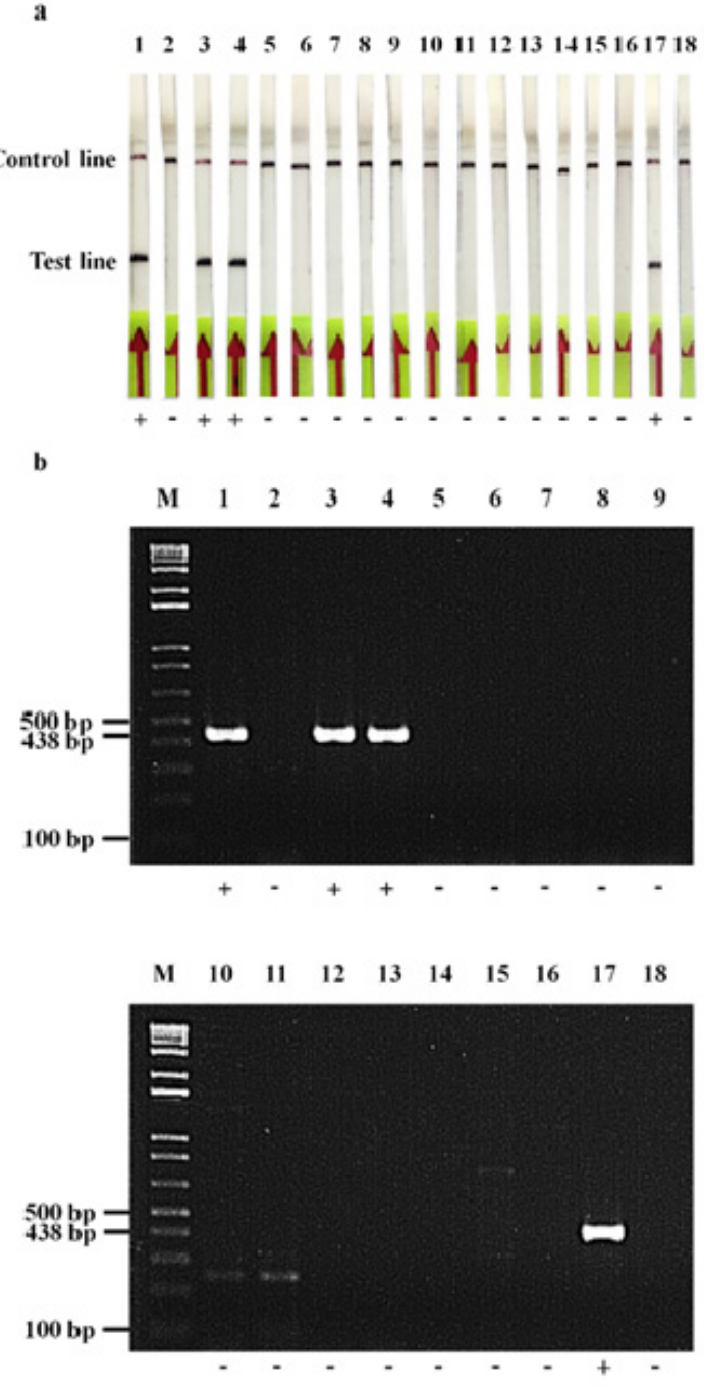
Figure 3. The RPA products of the bla OXA-48-like from the reference strains and clinical isolates detected by the RPA-LF ( a ), and PCR-AGE ( b ), assays. M, 1 kb plus DNA ladder; 1, bla OXA-48 positive control strain; 2, negative control strain; 3, E. coli ( bla OXA-48-like ); 4, E. coli ( bla OXA-181 ); 5, K. pneumoniae ATCC BAA-1705 ( bla KPC-2 ); 6, E. cloacae ( bla IMI-1 ); 7, E. coli ( bla NDM ); 8, K. pneumoniae ( bla IMP-14a ); 9, P. aeruginosa ( bla VIM-2 ); 10, A. baumannii ( bla OXA-23 ); 11, A. baumannii ( bla OXA-58 ); 12, A. pittii ( bla OXA-72 ); 13, K. pneumoniae ( bla CTX-M-1-like ); 14, E. coli ( bla CMY-2 ); 15, E. coli ( bla VEB-like , bla CMY-8b ); 16, K. pneumoniae ( bla CTX-M-9 , bla SHV-12 , bla VEB-like ); 17, K. pneumoniae ( bla NDM , bla OXA-48 ); 18, A. baumannii ( bla NDM , bla OXA-23-like , bla OXA-58